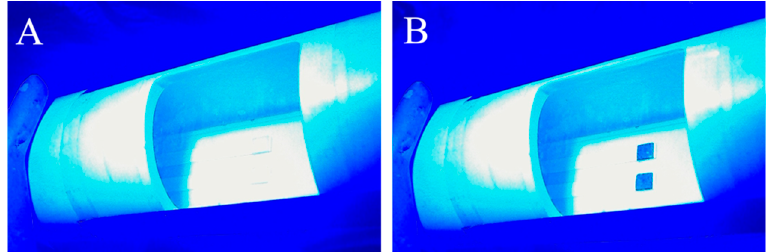
Figure 3. A reflected image from two XploSafe PS test-strips ( A ) before and ( B ) after exposure to a hydrogen peroxide gas at a concentration of 28 ppm for one hour.